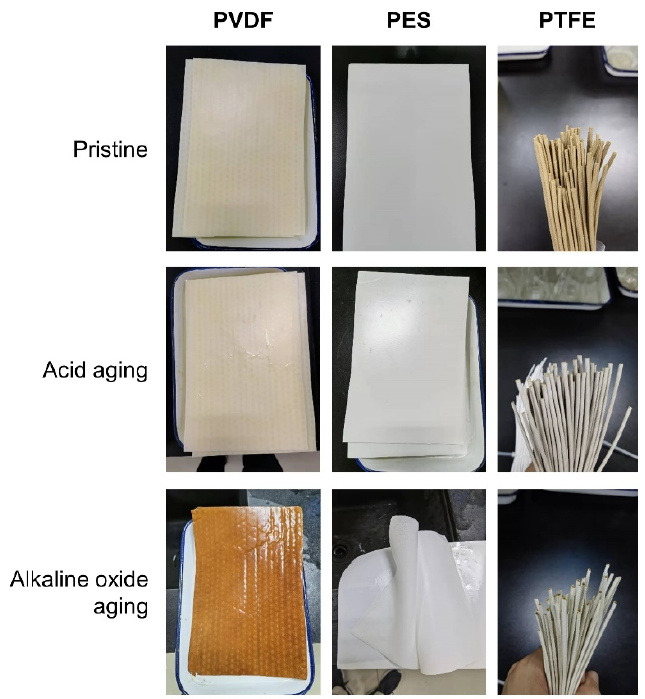
Figure 7. Photographs of the pristine and aged (five-years equivalent) membrane in the batch aging test.